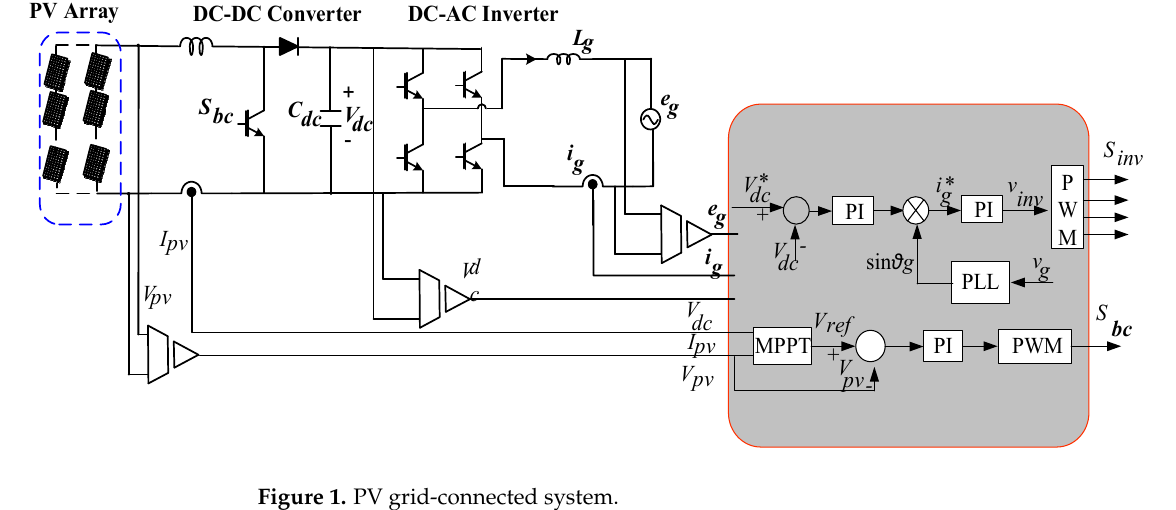
Figure 1. PV grid-connected system.